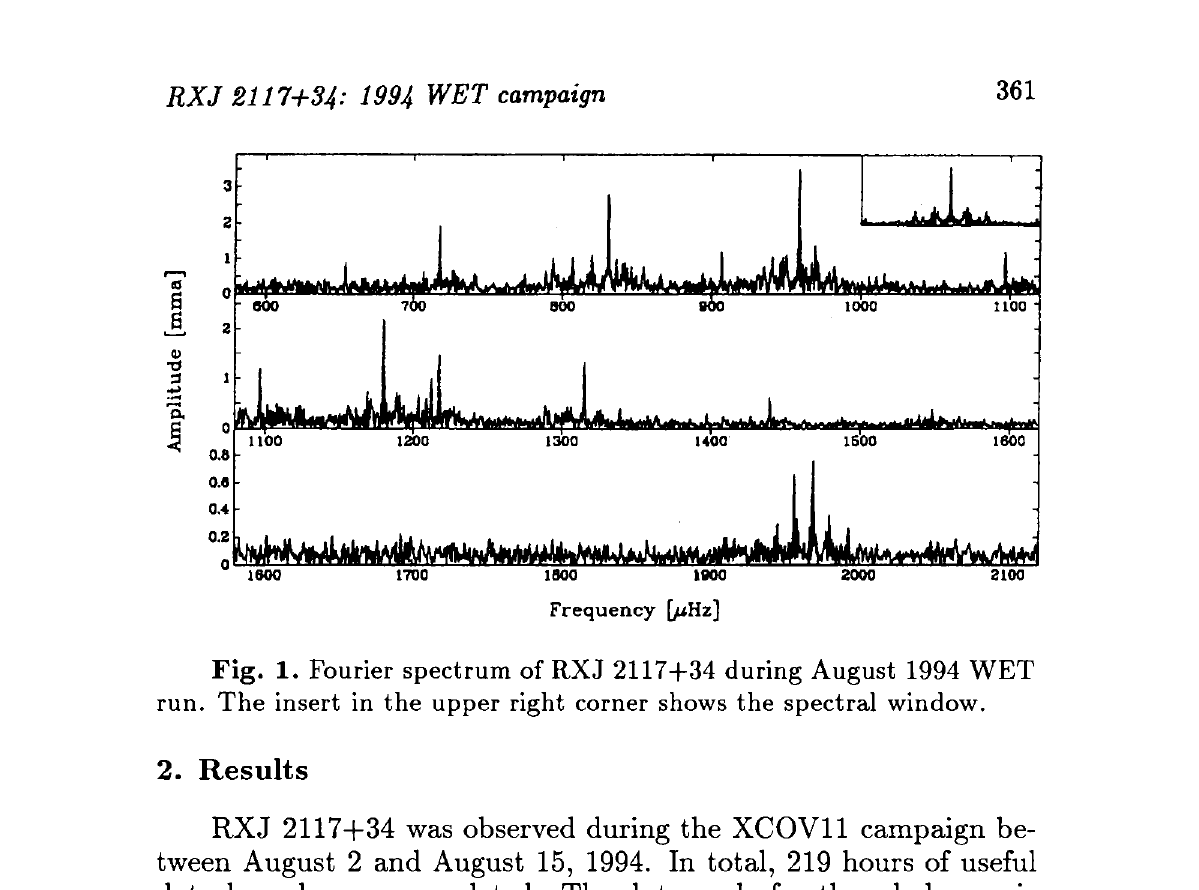
Fig. 1. Fourier spectrum of RXJ 2117+34 during August 1994 WET run. The insert in the upper right corner shows the spectral